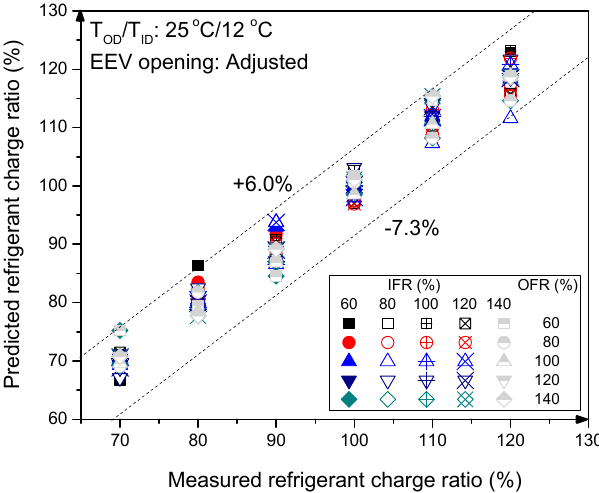
Figure 11. Error threshold of refrigerant charge for simultaneous refrigerant charge fault, indoor heat exchanger flow rate fault and outdoor heat exchanger flow rate fault.